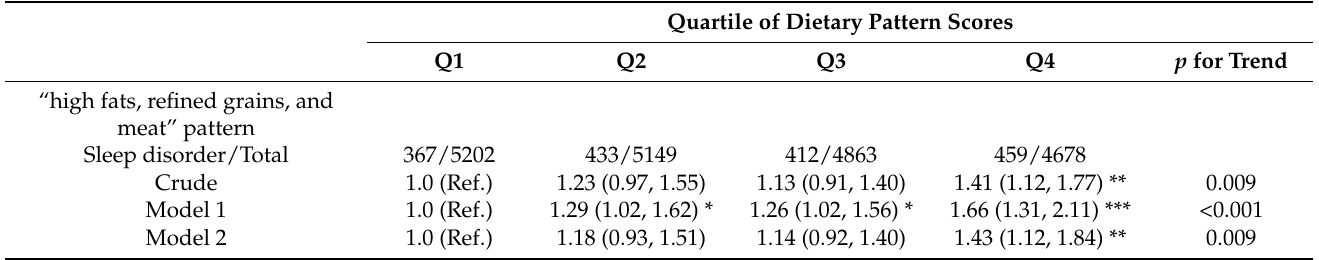
Table 2. Odds ratios of sleep disorders and corresponding 95% CIs according to quartiles of dietary pattern scores from partial least squares 1